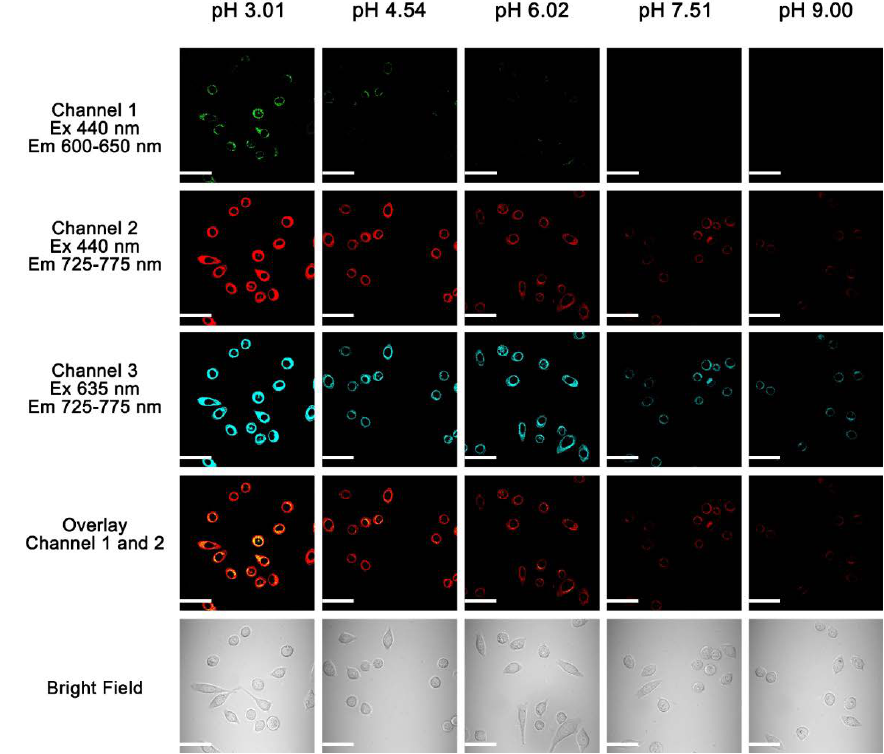
Figure 14. Confocal fluorescence images of HeLa cells incubated with probe B + in different pH buffers containing 10 µM nigericine with scare bars at 50 µm.